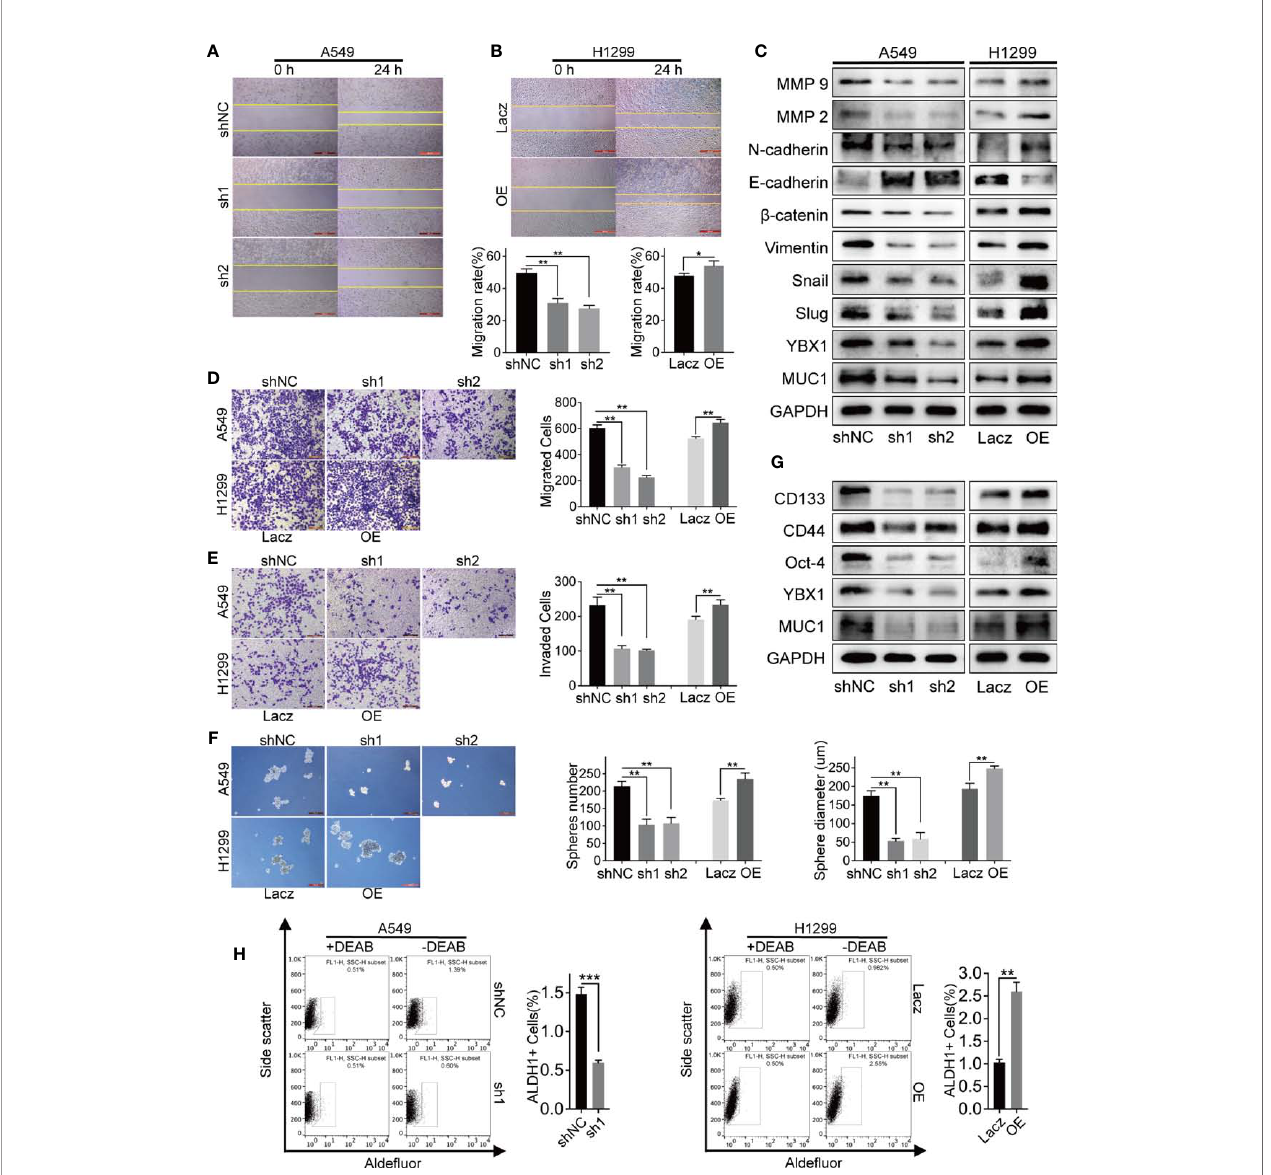
FIGURE 3 | The expression levels of YBX1 affected lung adenocarcinoma cells migration, invasion, and stemness. (A, B) The wound healing assay analyzed cell migration in A549 and H1299 cells, and YBX1 expression affected the migration rate. (C) YBX1 expression affected the EMT signaling and MMPs family. (D) The transwell assay without matrigel analyzed cell migration in A549 and H1299, and YBX1 expression affected the migrated cells number. (E) The transwell assay with matrigel analyzed cell invasion in A549 and H1299, and YBX1 expression affected the invaded cells number. (F) The sphere formation analyzed cancer cell stemness in A549 and H1299 cells. The number and diameter of the spheres were affected by YBX1 expression. (G) The markers related to stemness were detected by western blot, includingCD44, CD133, Oct-4. (H) ALDH1 positive population analysisrevealed that decreased expression of YBX1 reduced the ALDH1+ cell proportions, whereas overexpression ofYBX1increased the proportion.The data are presented as mean ± SDofthree independenttests. *P < 0.05, **P < 0.01, ***P <